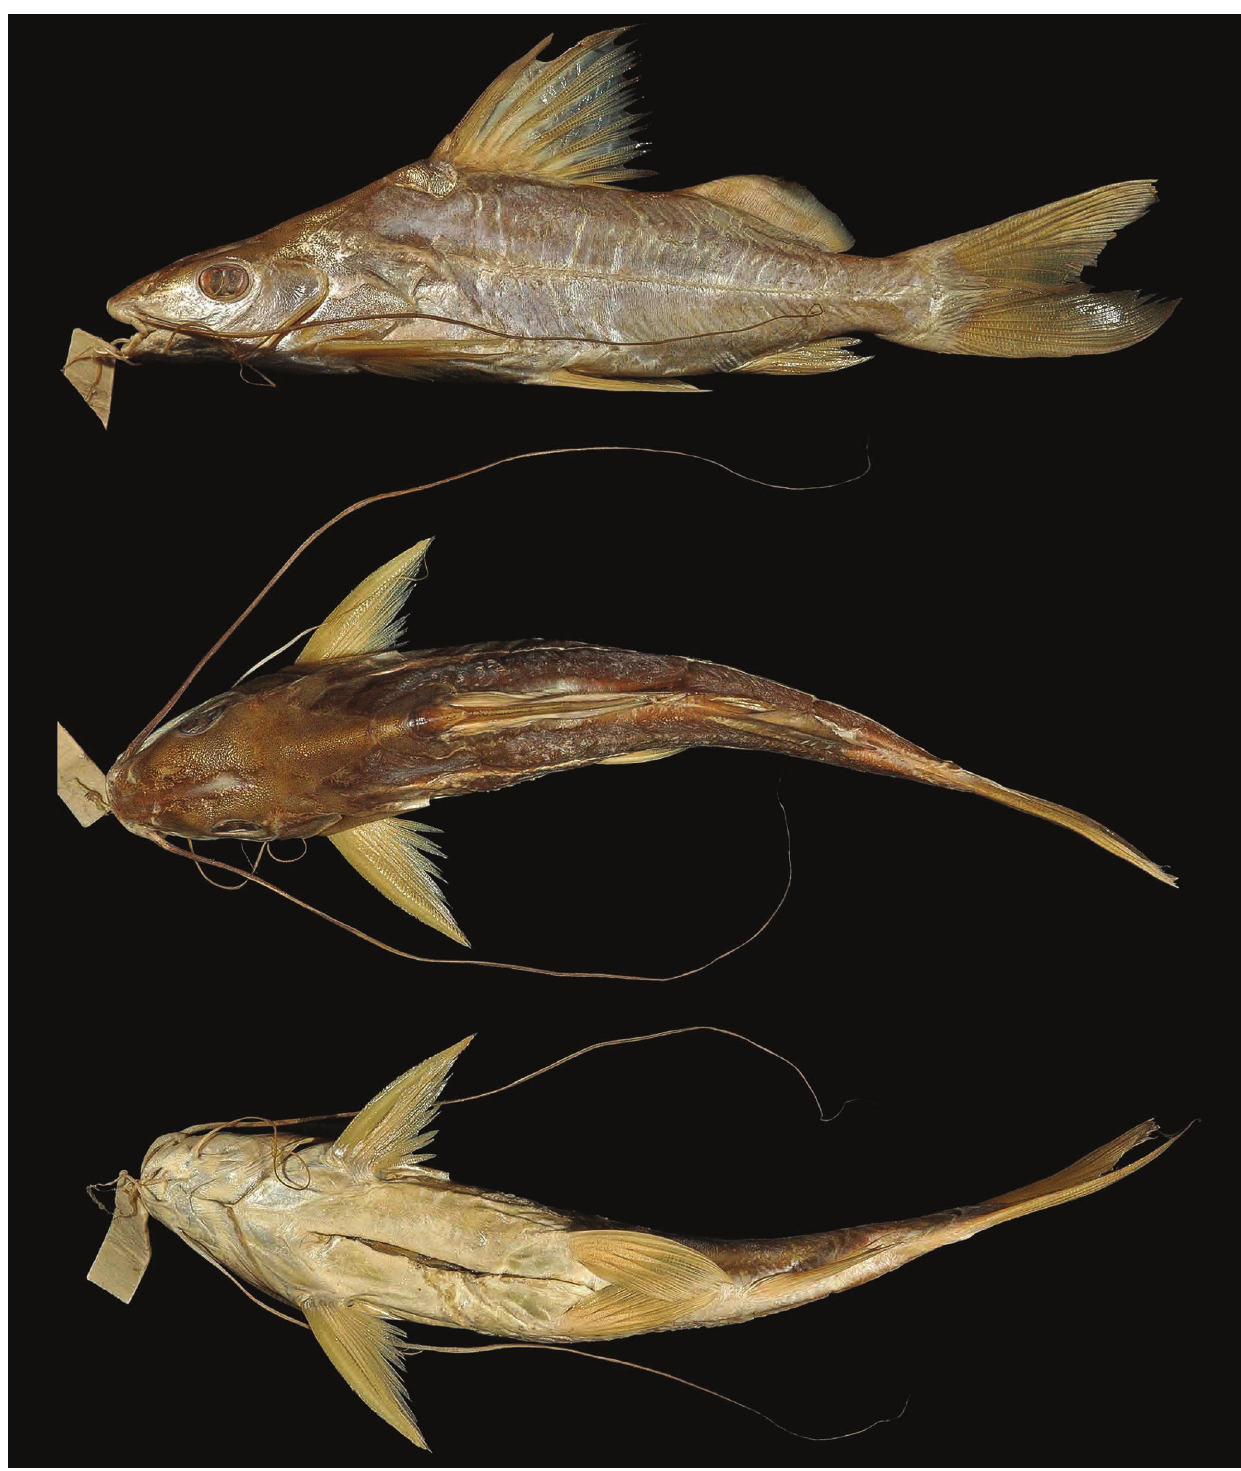
Fig. 6. Pimelodus argenteus , syntype, MSNG 14570, 165 mm SL, río de la Plata, río Paraná, Colonia Resistencia [Departamento San Fernando], Argentina. Photo by Mark